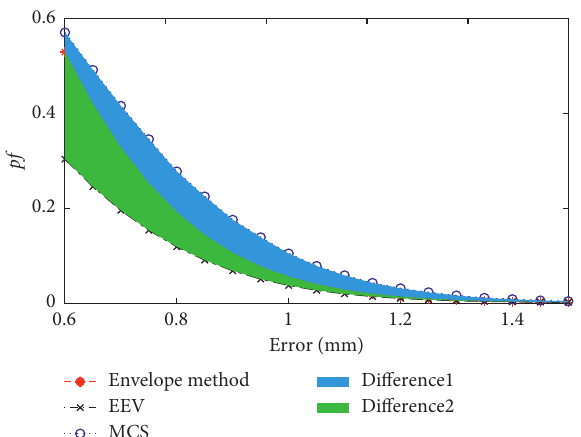
Figure 12: Comprehensive reliability of the